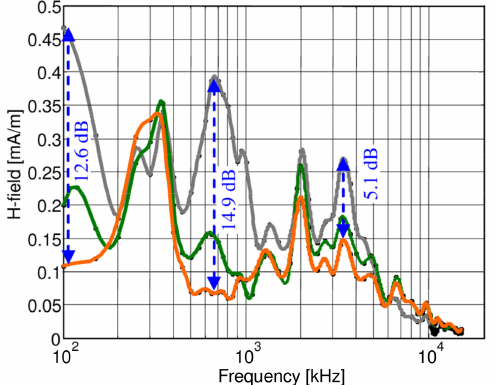
Figure 9. H-field intensity measured to qualify a short test track (metro line with third rail supply) [59]: three distances, d = 4 m (gray), 6 m (green), and 10 m (orange); height above ground of the base of loop antenna h = 0.25 m. The spread between curves in dB at the three major frequency points is indicated in